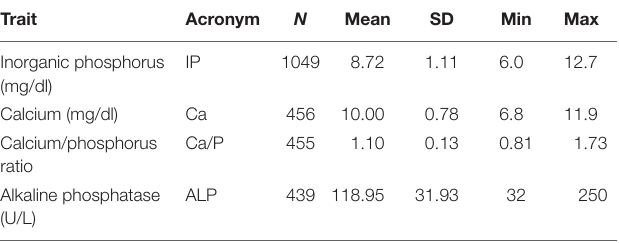
TABLE 1 | Descriptive statistics of blood traits in German Landrace pigs.